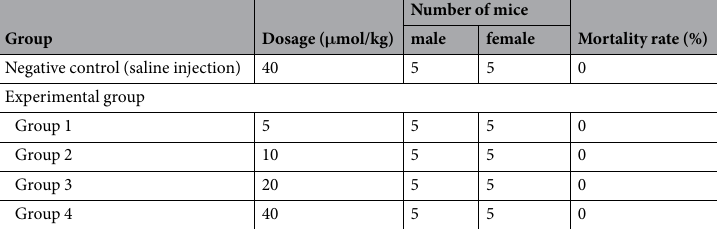
Table 3. Mouse mortality at different inoculation doses of